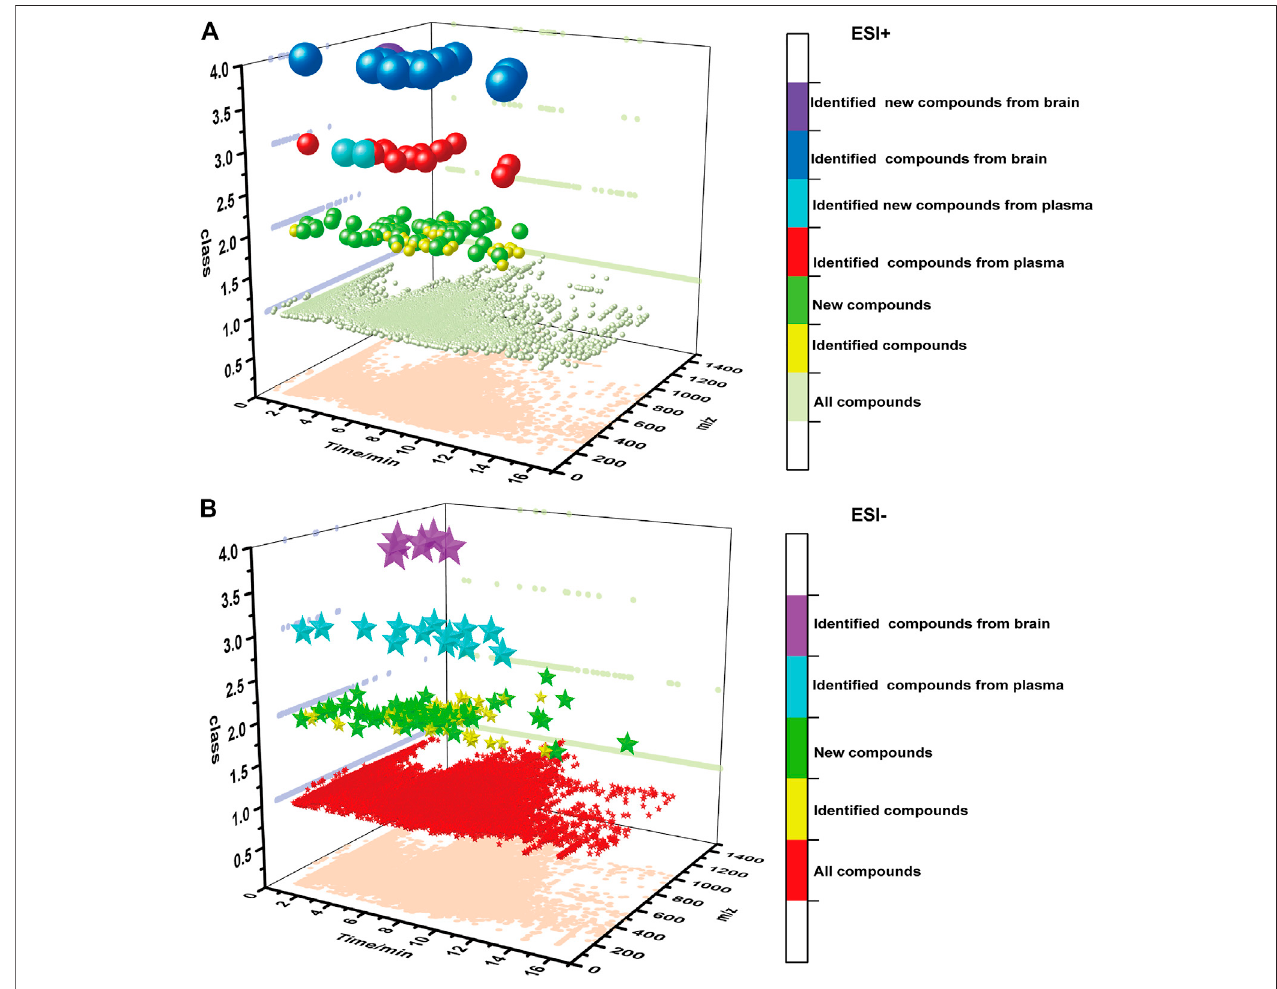
FIGURE 6 | Information of the chemical compounds of Zhi-Zi-Hou-Po decoction under the positive ion mode( A ) and negative ion mode ( B ).